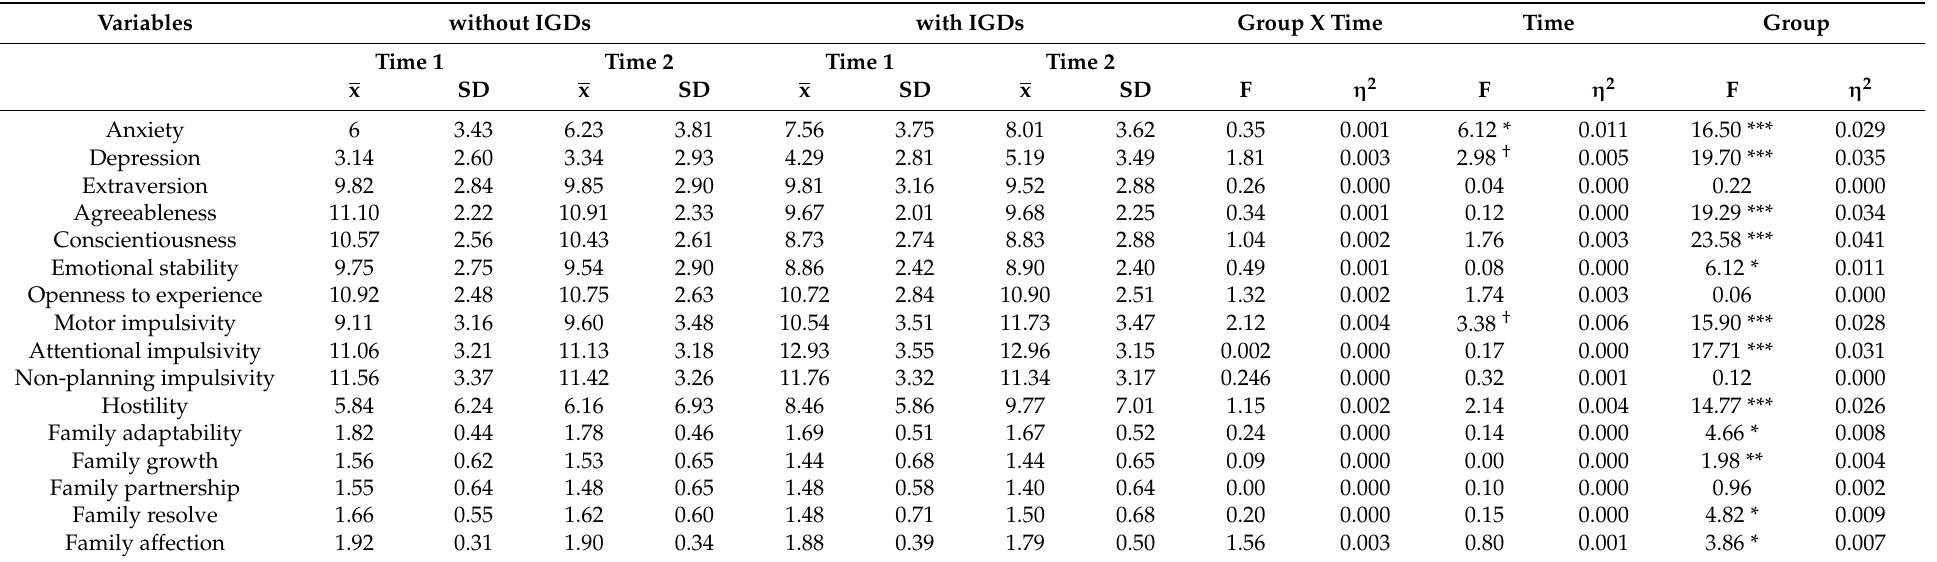
Table 2. Mean differences between the study variables between-group and